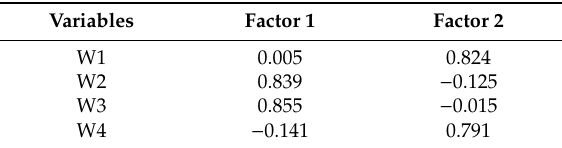
Table 8. Factor loadings of perception disability in work